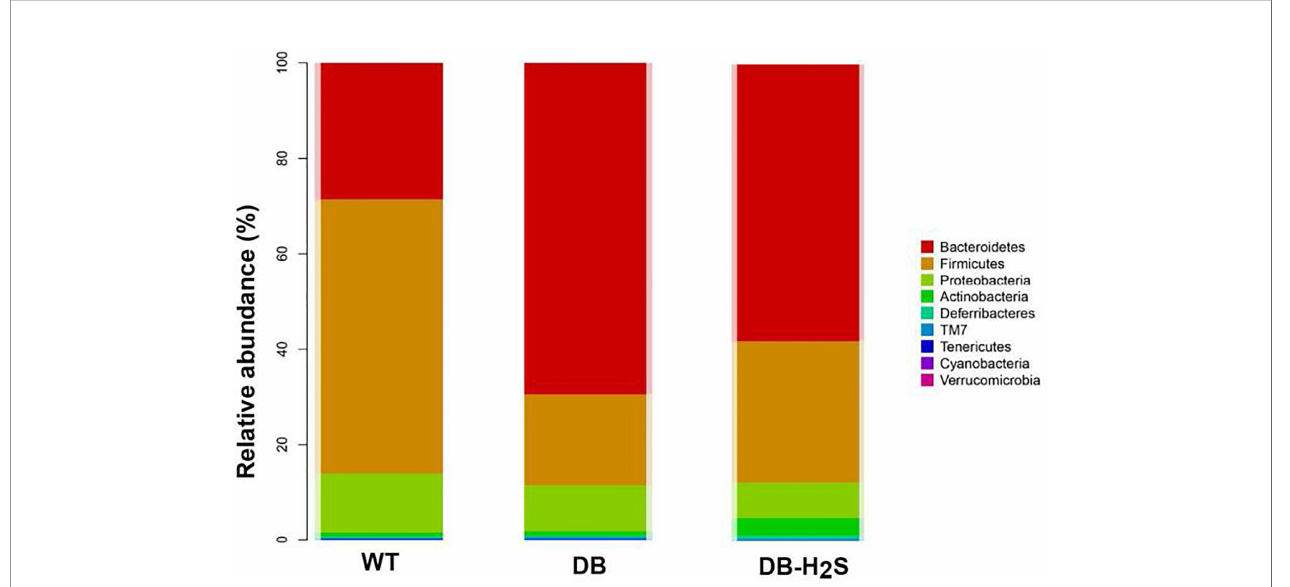
FIGURE 4 | Effect of exogenous H 2 S on the gut microbiota composition. Changes in bacterial taxonomic composition of the gut microbiota at the phylum level. WT, wild-type mouse group (n = 6); DB, db/db mouse group (n = 6); DB-H 2 S, db/db mouse treated with NaHS group (n =